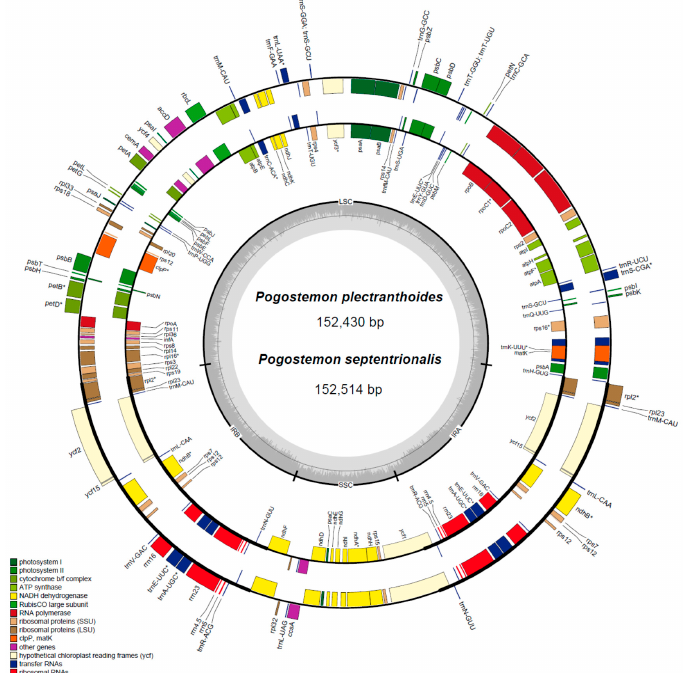
Figure 1. Physical map of two chloroplast genomes from Pogostemon plectranthoides (outer circle) and Pogostemon septentrionalis (inner circle). Genes inside the circle are transcribed clockwise and those outside are transcribed counterclockwise. The light gray inner circle corresponds to the AT content and the dark gray circle to the GC content. Genes belonging to different functional groups are shown in different colors. Asterisks indicate intron-containing genes.